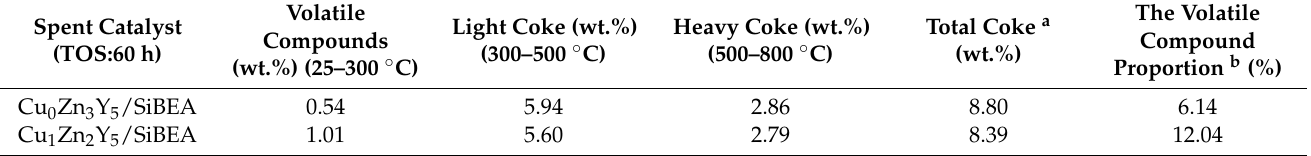
Table 5. The carbon deposition distribution of spent catalysts by TGA.